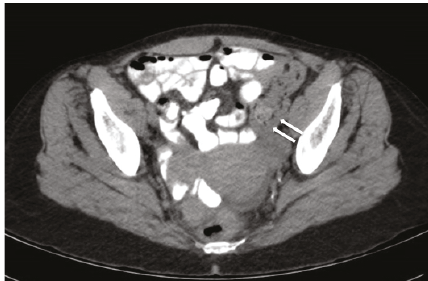
Figure 1: Sigmoid colonic wall thickening represented by white arrows near the area of stricture.